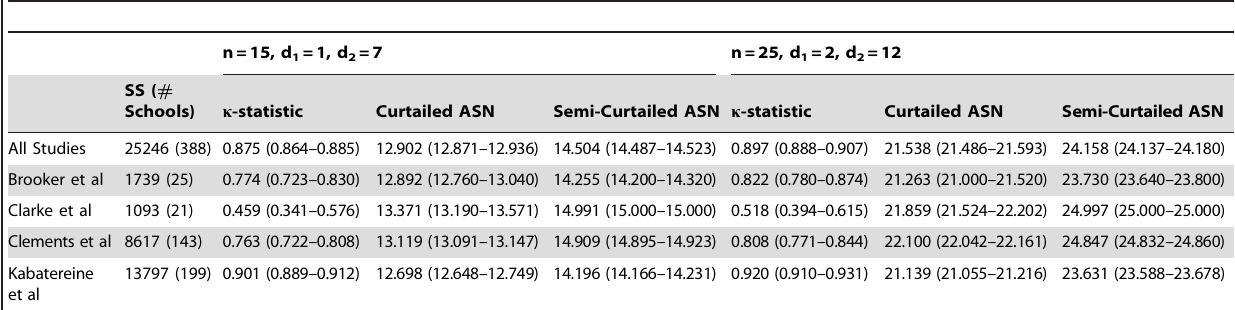
Table 1. Kappa-statistic, Curtailed Average Sample Number, and Semi-curtailed Average Sample Number in four studies for two different MC-LQAS